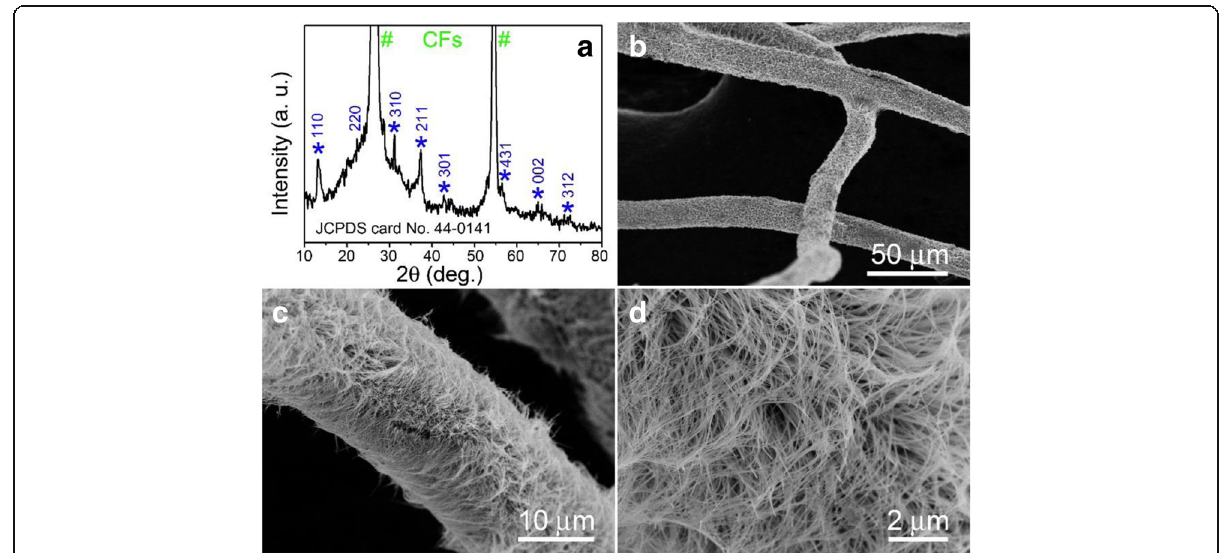
Fig. 1 a XRD pattern of the as-grown MnO 2 nanowires on carbon fibers. b – d Different-magnification SEM images of the CF@MnO 2 NWA